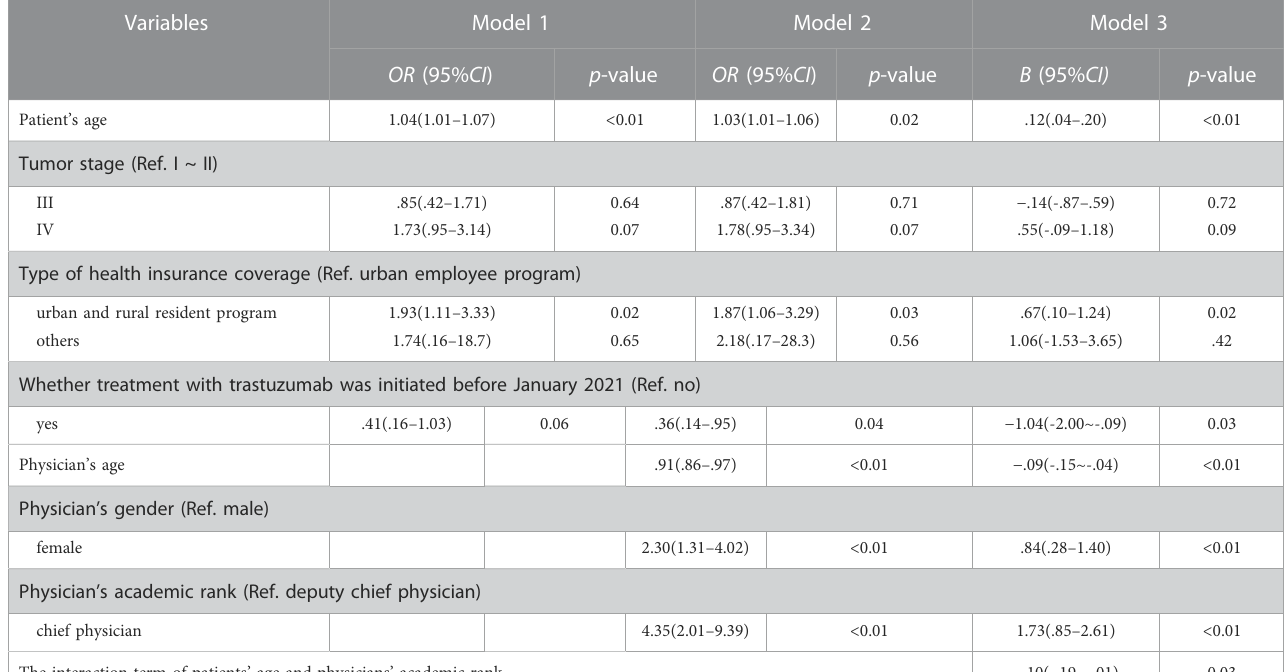
TABLE 3 Logistic regression analysis of the associated factors of biosimilar uptake ( n = 446).